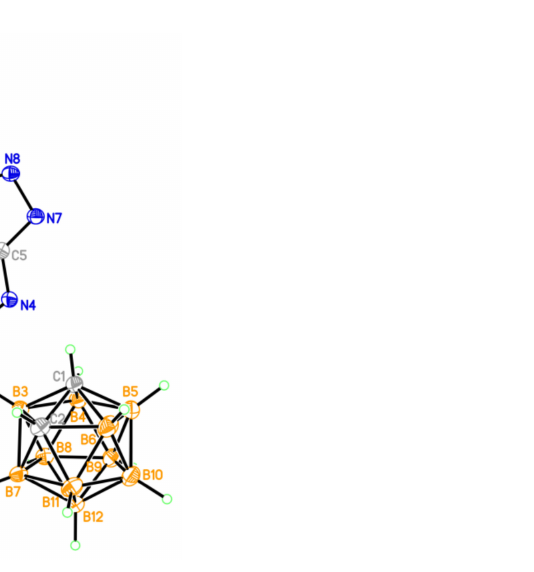
Figure 5. Molecular structure of compound 19 (thermal ellipsoids are drawn at the 50% probability level).